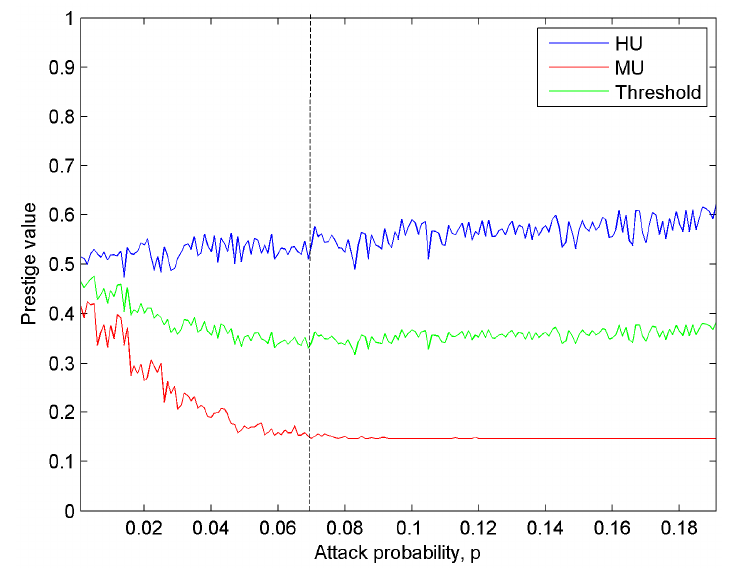
Figure 5. Reputation value of cognitive users under different attack probabilities.